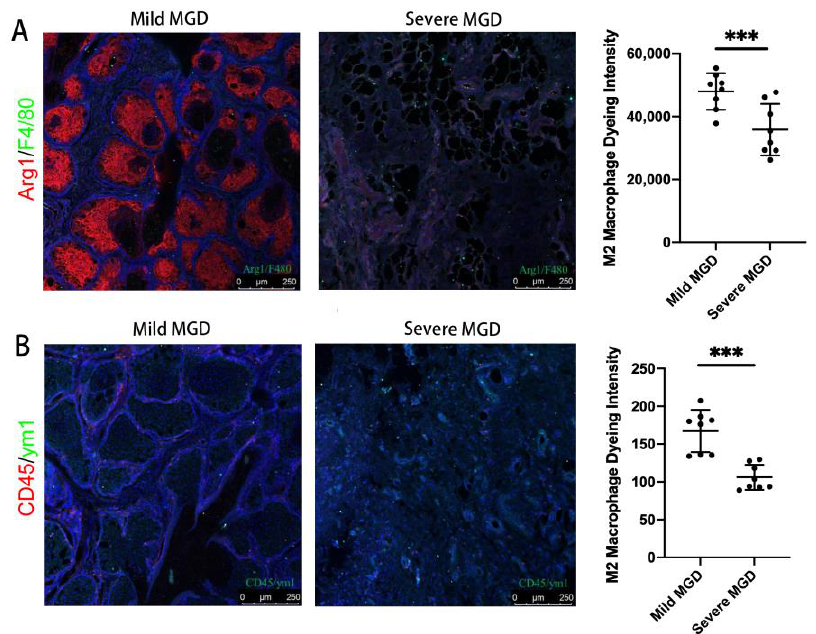
Figure 4. Immunofluorescence staining of M1 and M2 macrophages in MG tissues of mild and severe MGD patients. ( A ) The results showed that the expression levels of Arg1 (marker of M2) in MG tissues were significantly lower in severe MGD group than those in mild MGD group ( p = 0.0041). ( B ) The results showed that the expression levels of ym1 (marker of M2) in MG tissues were signifi- cantly lower in the severe MGD group than those in the mild MGD group ( p = 0.0001) (*** p < 0.001).